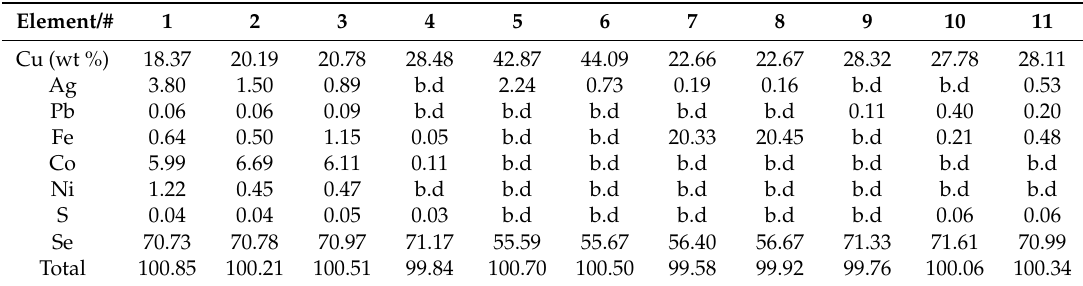
Table 2. Representative results of the electron-microprobe analyses of krut’aite, klockmannite, eskebornite, and petˇr í ˇcekite.